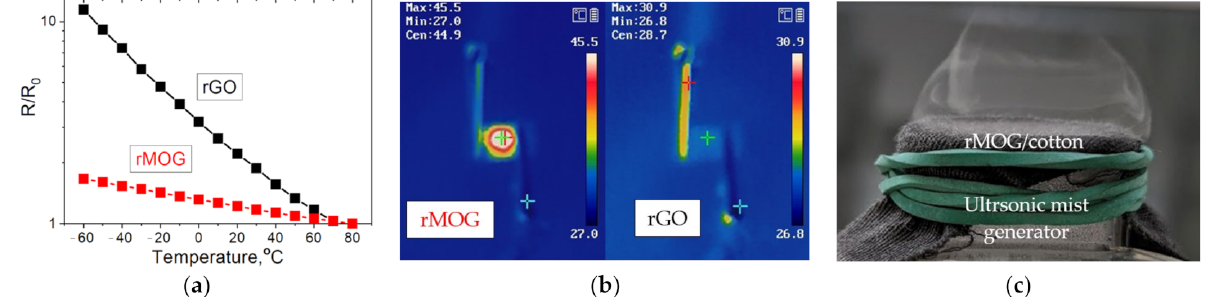
Figure 10. Demonstration of the practical application of rMOG e-textiles: ( a ) sensitivity of electrical resistance of rGO and rMOG to temperature; ( b ) demonstration of the heating performance of rGO and rMOG; ( c ) demonstration of rMOG/cotton